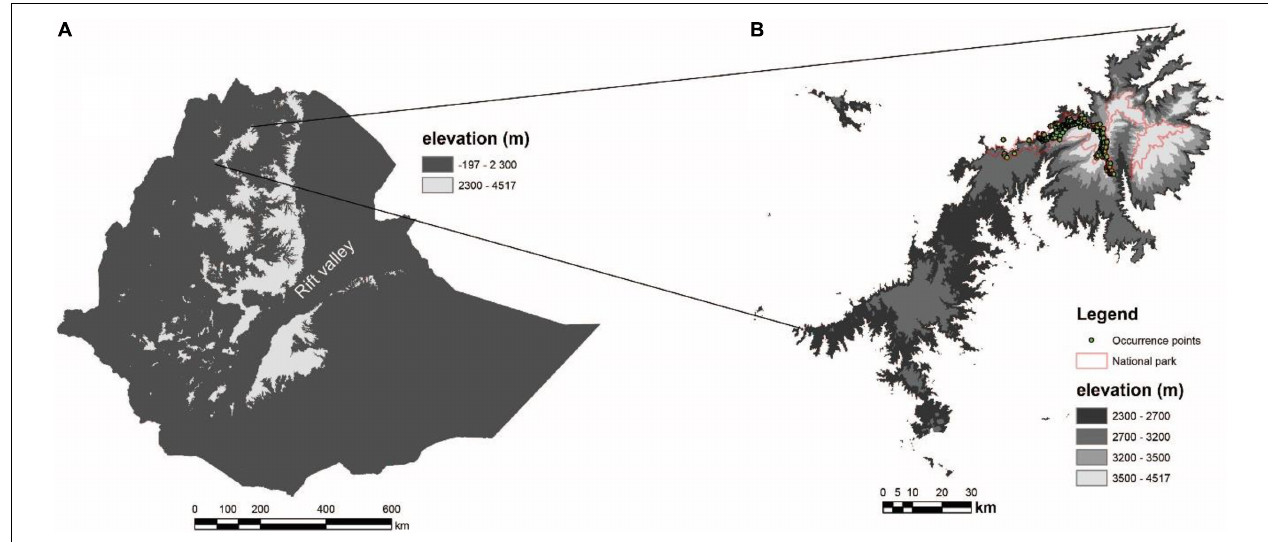
FIGURE 1 | Study area showing the Ethiopian highland masses above 2,300 m (A) and Simen Mountains (B) , the only place where the Walia ibex is extant today. The park boundary and the occurrence points used in the models are indicated in (B) .